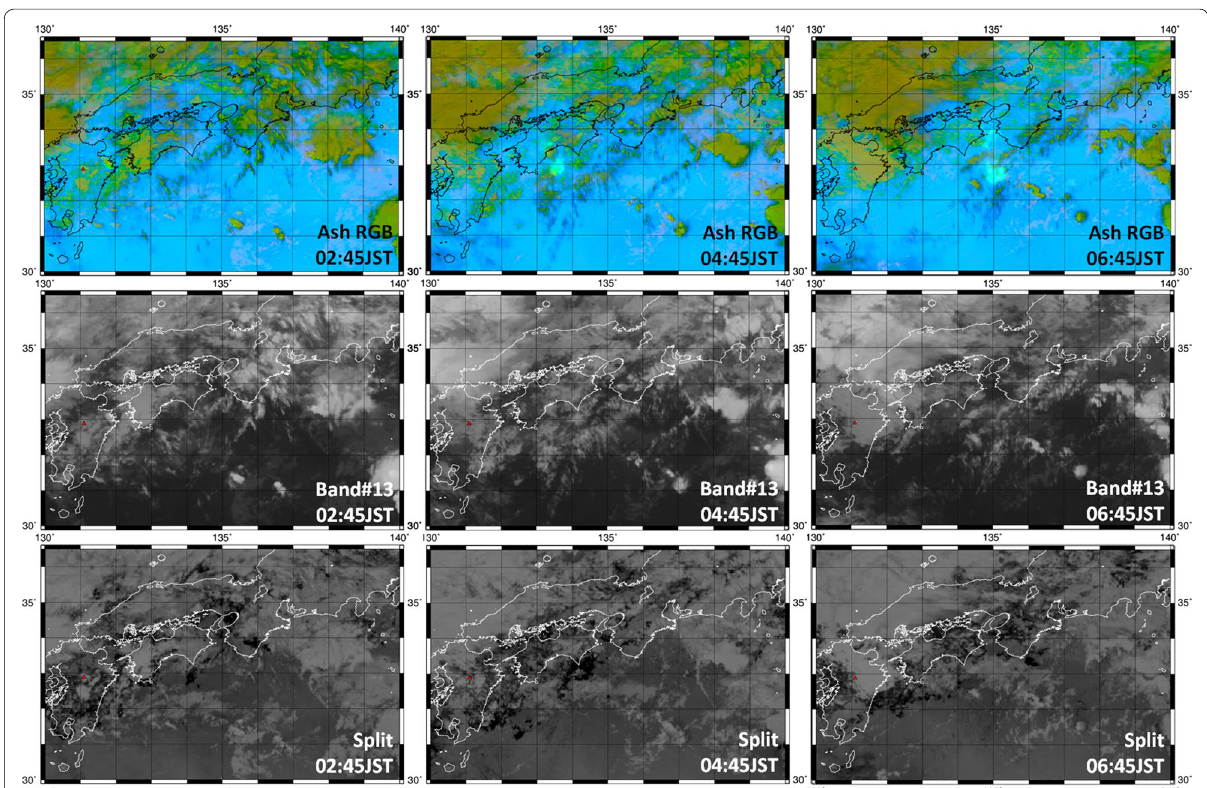
Fig. 3 The Ash RGB (upper row), band #13 image (middle row) and split window (band #13–#15) image (bottom row). The left column is 02:45JST (approximately 1 h after eruption), the center column is 04:45JST (approximately 3 h after eruption), and the right column is 06:45JST (approximately 5 h after